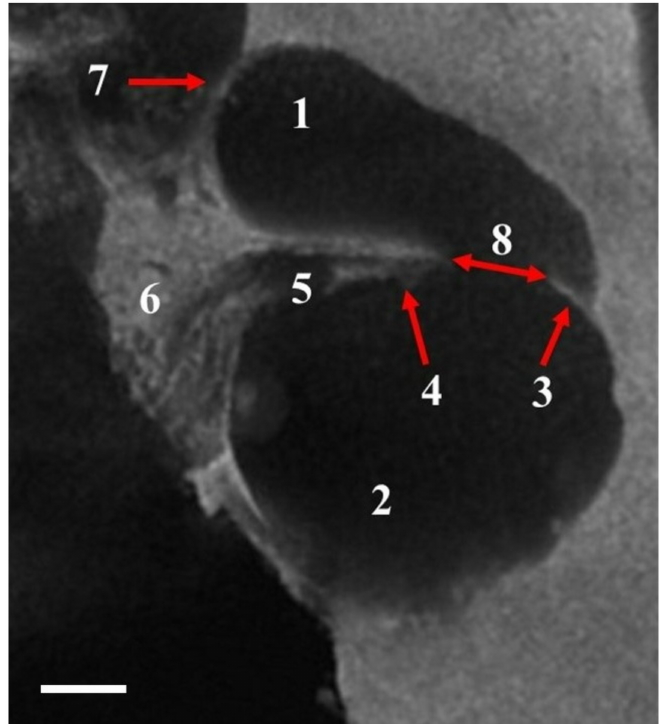
Figure 3. Cross section of the spiral cochlear canal at level of the basal turn. 1, scala vestibuli; 2, scala tympani; 3, secondary spiral lamina (only in the basal turn); 4, osseous spiral lamina; 5, spiral cribriform tract containing the spiral ganglion; 6, modiolus; 7, lamina of modiolus; 8, space containing the basal membrane. Scale bar = 400 µ